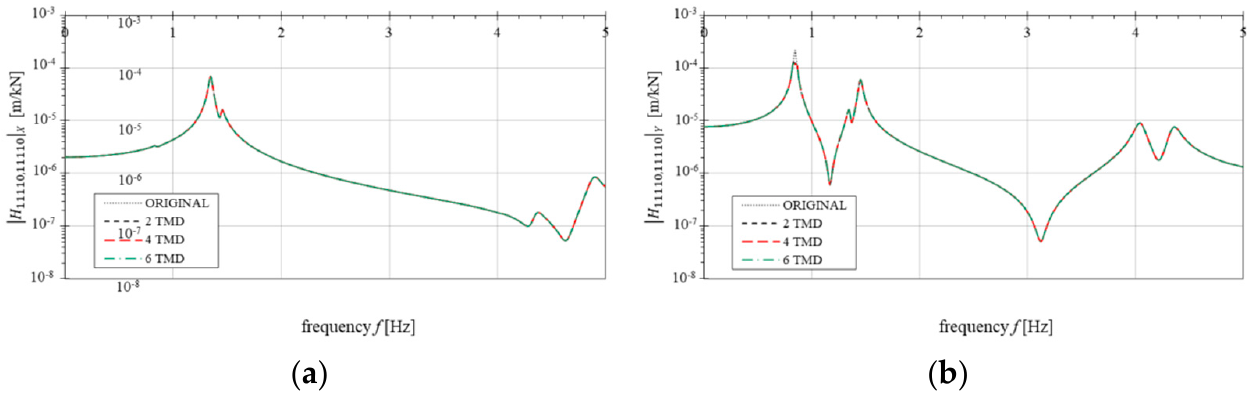
Figure 22. Module graph of the FRF in node 11,110 for optimal TMD parameters ( J 2) and a different number of TMDs: ( a ) for X direction; ( b ) for Y direction.